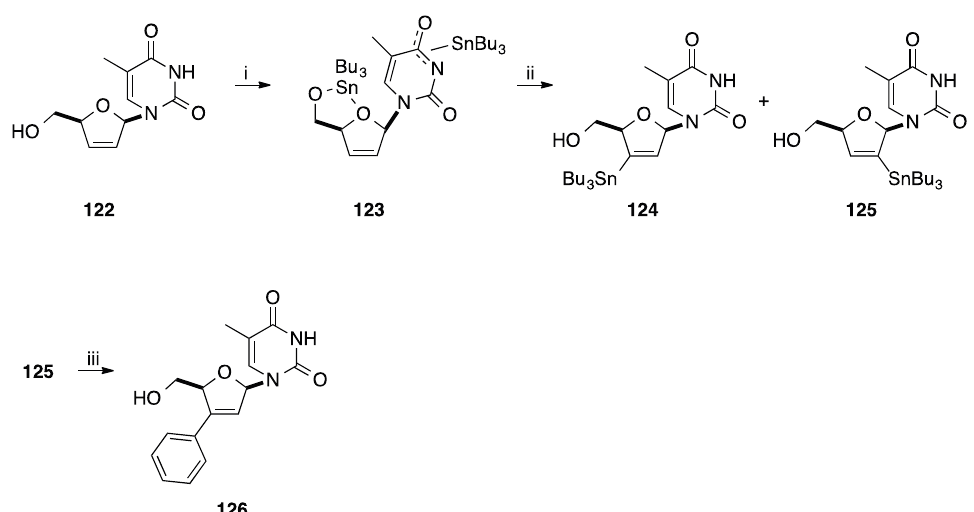
Scheme 14. Synthesis of 2'- C -phenyl d4U analogue 121 .